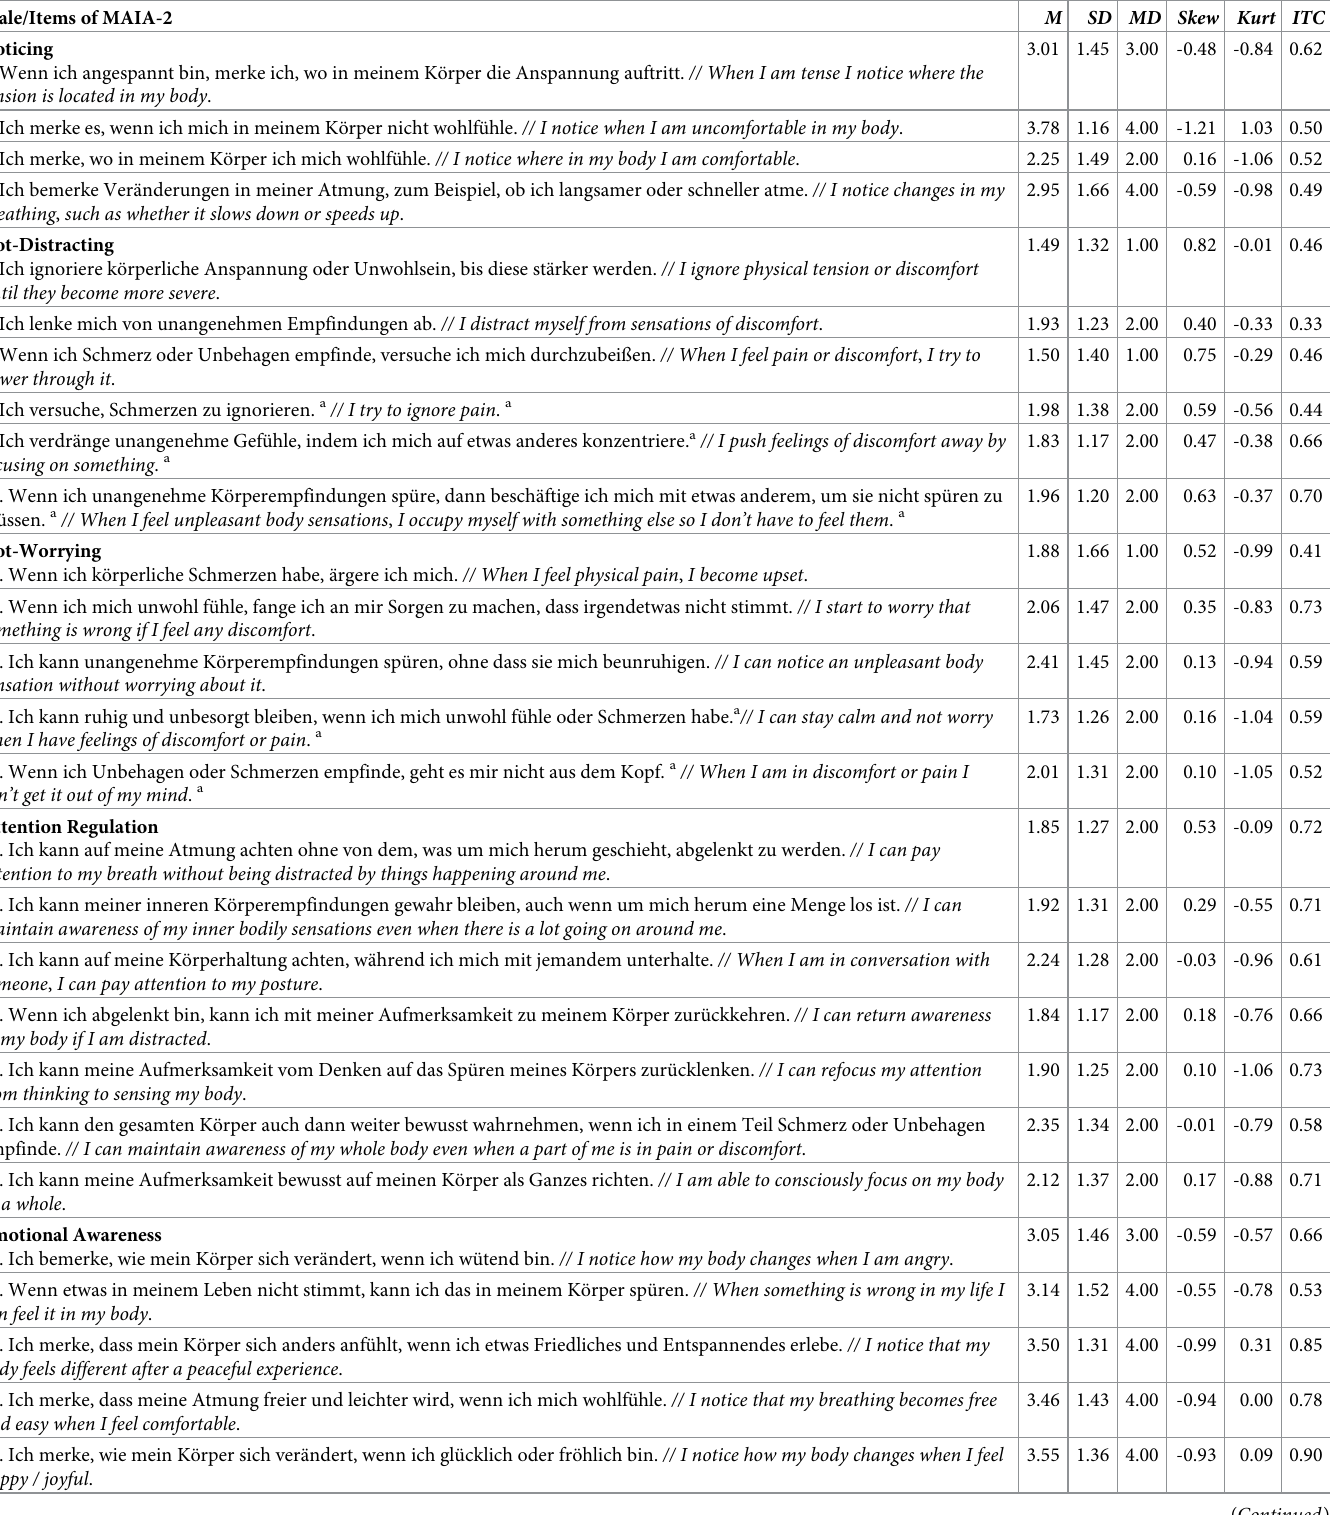
Table 2. Item analysis and descriptive statistics of MAIA-2 (pre-treatment, n = 110). Scale/Items of MAIA-2 M SD MD Skew Kurt